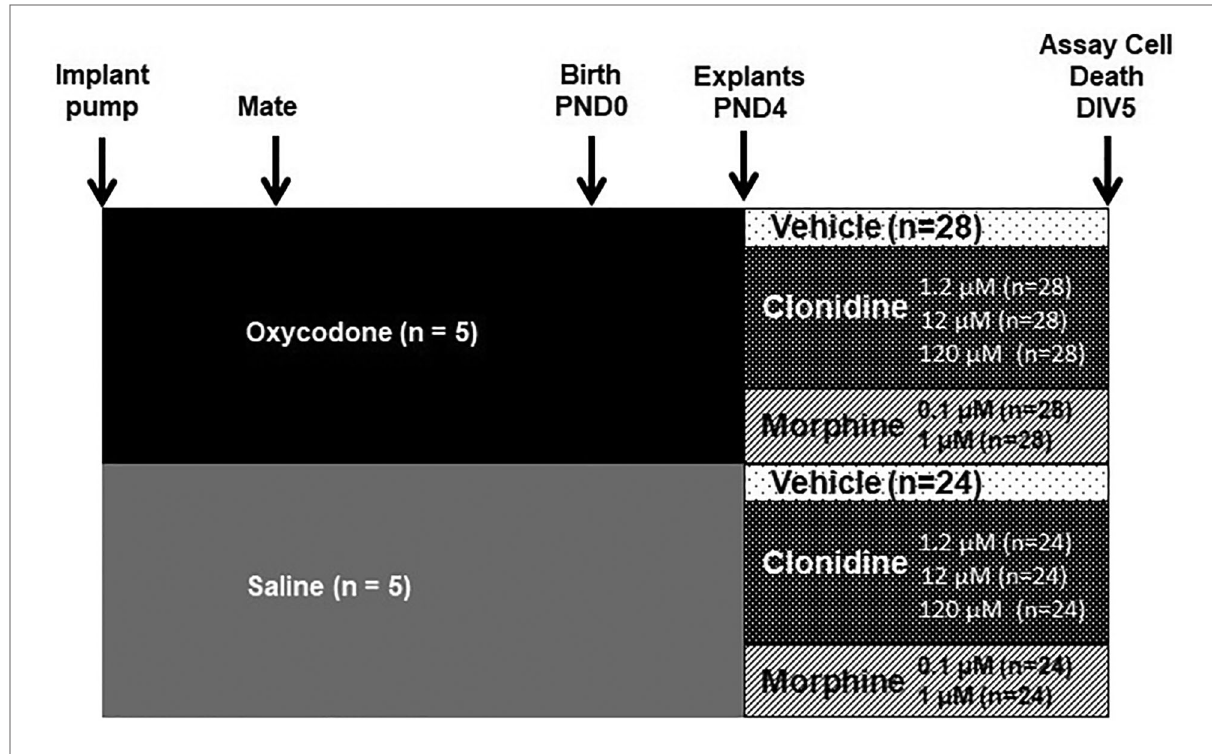
FIGURE 1 Schematic of pre- and post-natal treatment